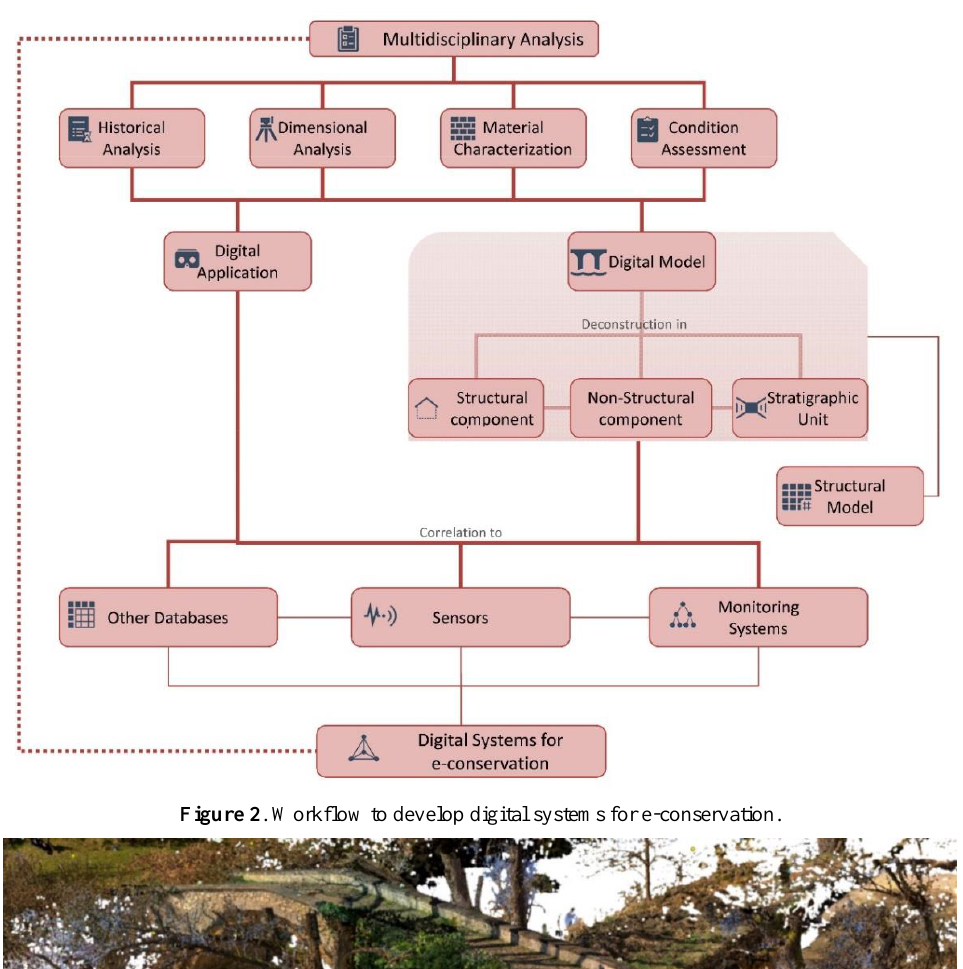
Figure 2 . Workflow to develop digital systems for e-conservation.